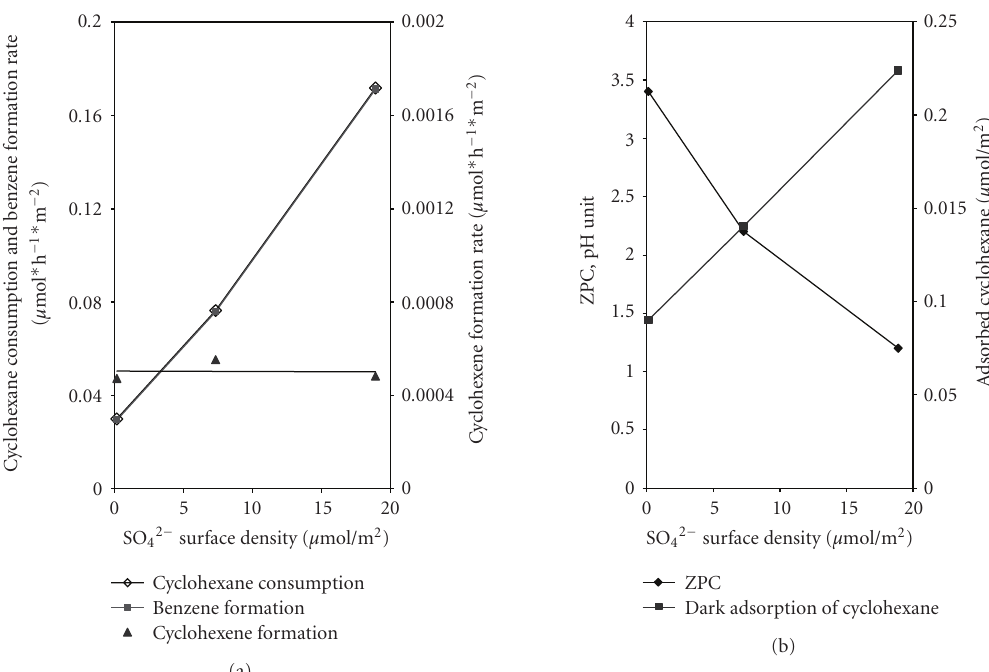
Figure 8: Cyclohexane consumption rate, benzene and cyclohexene formation rate (a) ZPC values and dark adsorption of cyclohexane (b) as function of sulphate surface density on 24MoPC500, 17MoPC500S10, and